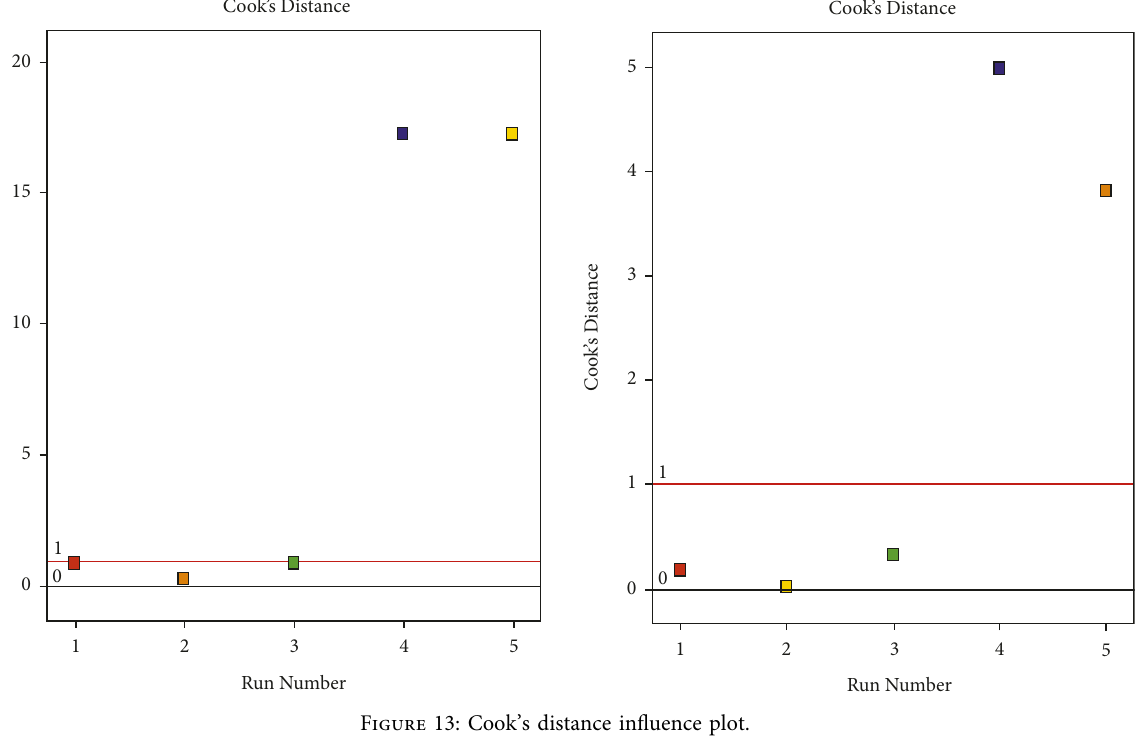
Figure 13: Cook’s distance influence plot.